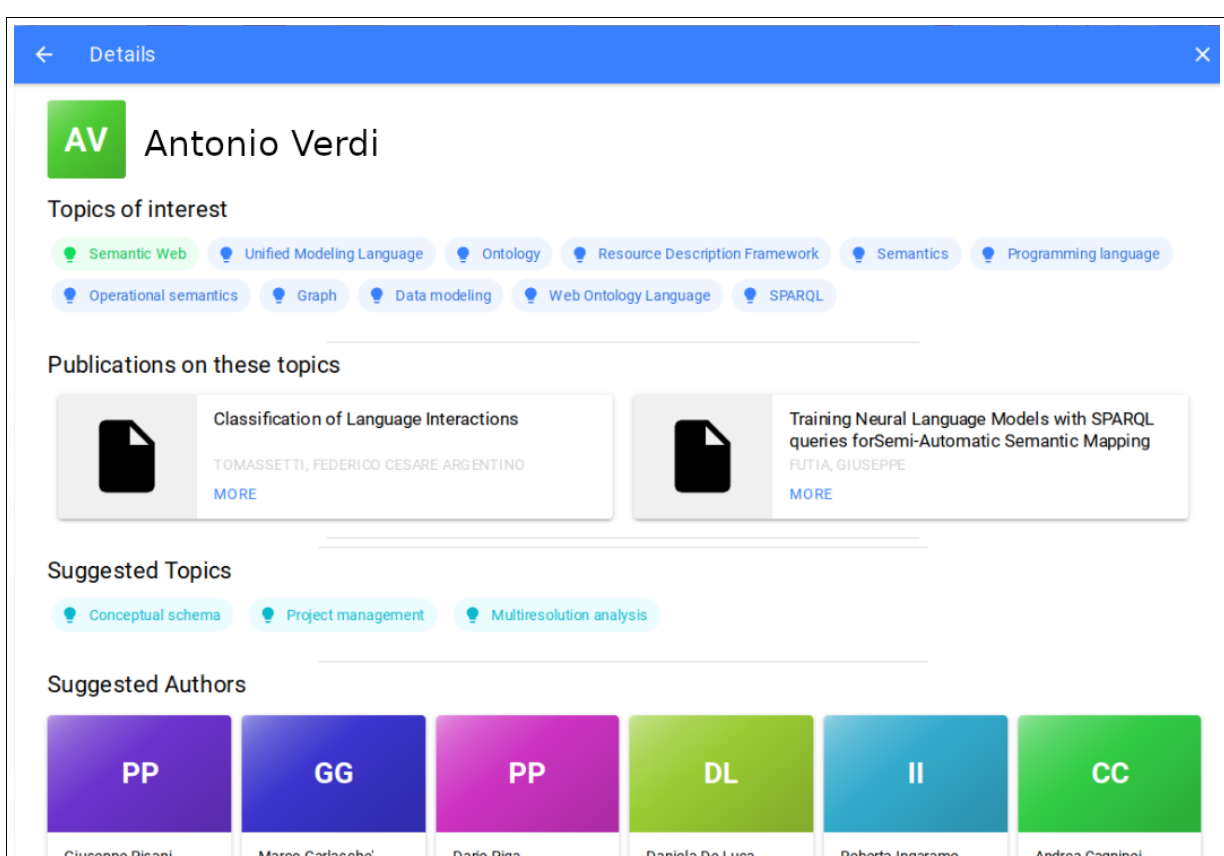
Figure 5. Screenshot of the Geranium Web App: results of the link-prediction-based recommendation